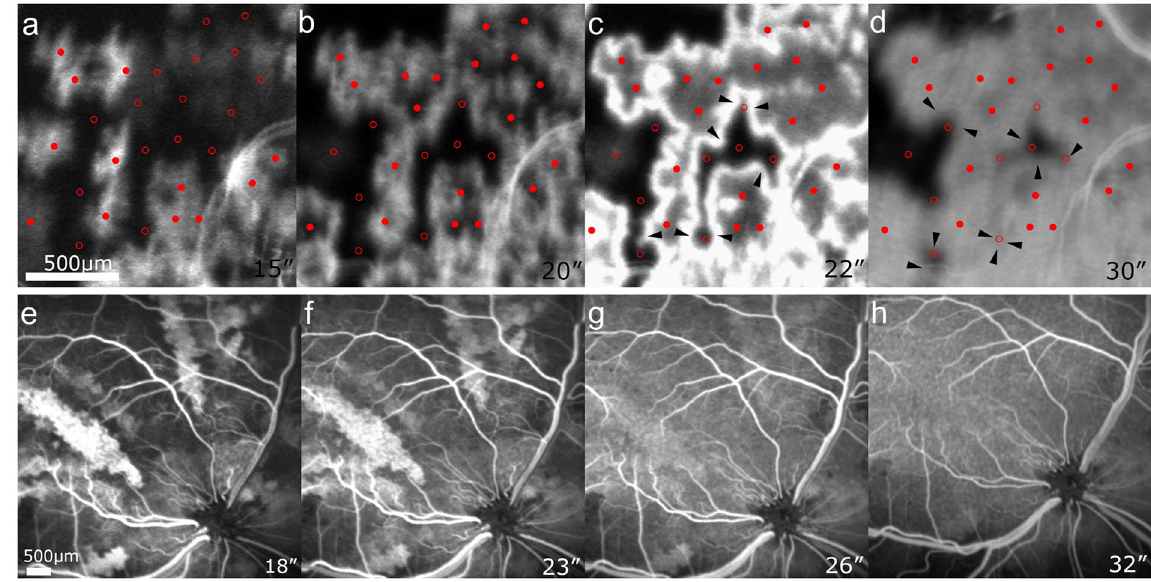
Figure 2. Fluorescein angiography obtained in cat eyes after triolein fat embolism. ( a – d ) Multiple hyperfluorescent and hypofluorescent patches are observed, representing perfused and embolized choriocapillaris lobules. Red dots and circles represent the locations of the perfused and embolized terminal arterioles, respectively. The expansion of the hyperfluorescent area clearly demonstrates the blood flow beyond the boundary of each lobule (arrowheads). ( e – h ) Sectorial hyperfluorescence and hypofluorescence represent the occlusion of the short posterior ciliary arteries. After approximately 10 seconds, perfusion defects were resolved without any subsequent